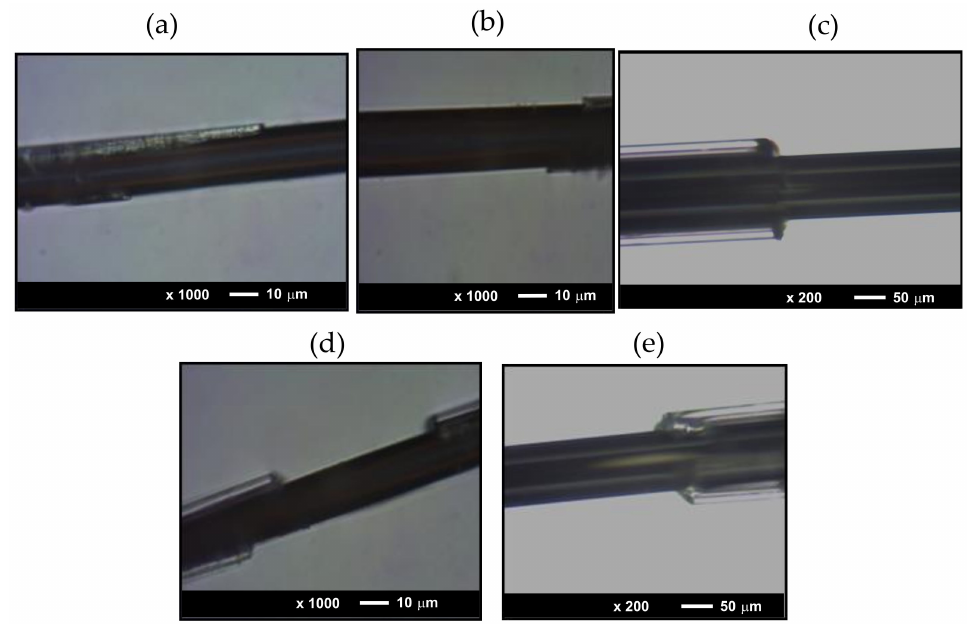
Figure 1. Imagesofstudiedsamples1–5( a – e )respectively.